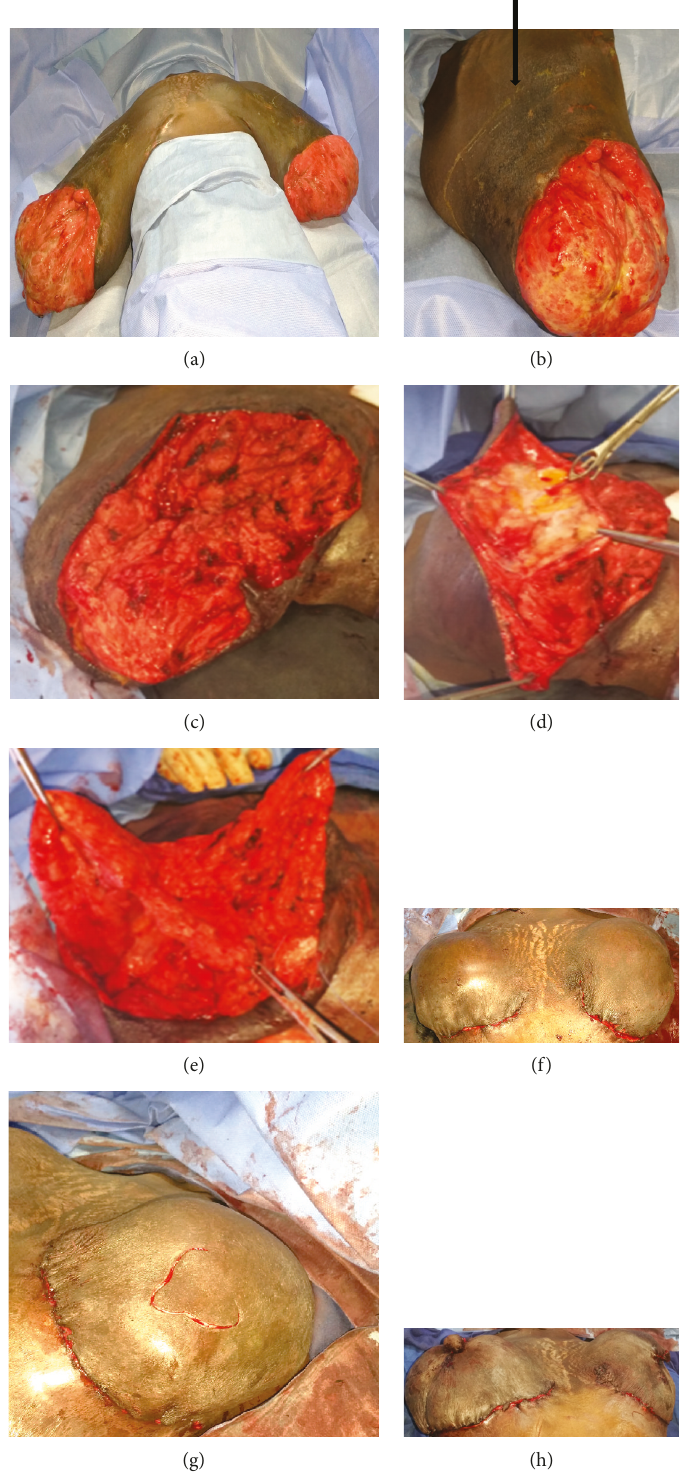
Figure 2: (a) Preoperative installation at D21 postpartum. (b) Arrow showing the incision site for the glandular section. (c) Glandular clean cut taking away the necrotic area and keeping the necessary mammary tissue for the plasty. (d) Skin fl ap lifting following the crests of Duret. (e) Glandular remodeling after reduction. (f) Cutaneous plasty. (g) Incision of the nipple plasty. (h) Cutaneous and nipple plasty (immediate